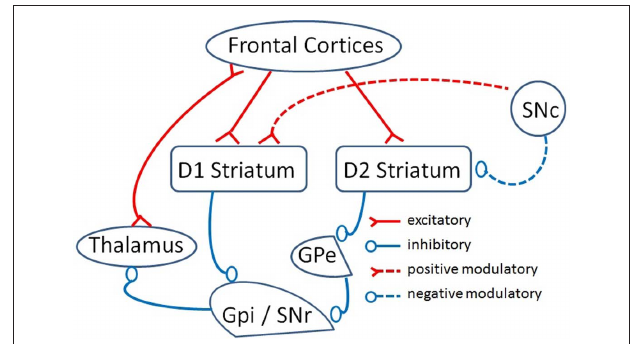
Figure 2 | A schematic model of direct and indirect pathways of Bg (adapted from Frank et al., 2004). The principal input of BG is the striatum, receiving excitatory inputs from most cortical areas. The output nuclei of BG are GPi/SNr, which direct processed information to the thalamus to eventually feed back an excitatory projection to the cortex. Within this circuitry, there are two pathways: a direct pathway expresses D1 receptors and indirect pathway expresses D2 receptors. D1 striatal neurons inhibit GPi/SNr cells forming the direct pathway. D2 striatal cells inhibit an intermediate relay, the GPe which ultimately provides inhibition to GPi/SNr. Under basal conditions, GPi/SNr cells fire at high level and maintain inhibition of the thalamus which in turn dampens corticostriatal loops activity. The different direct/indirect connectivity results in opposite effects: inhibitory effect on GPi/SNr and release of inhibition in thalamic activity by the direct pathway and excitatory effect on GPi/SNr and inhibitory effect on thalamus by the indirect